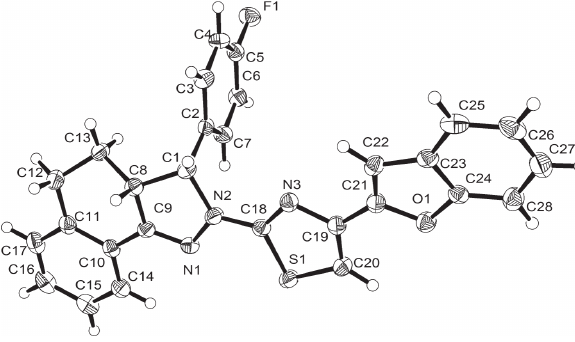
Table 1: Data collection and handling.